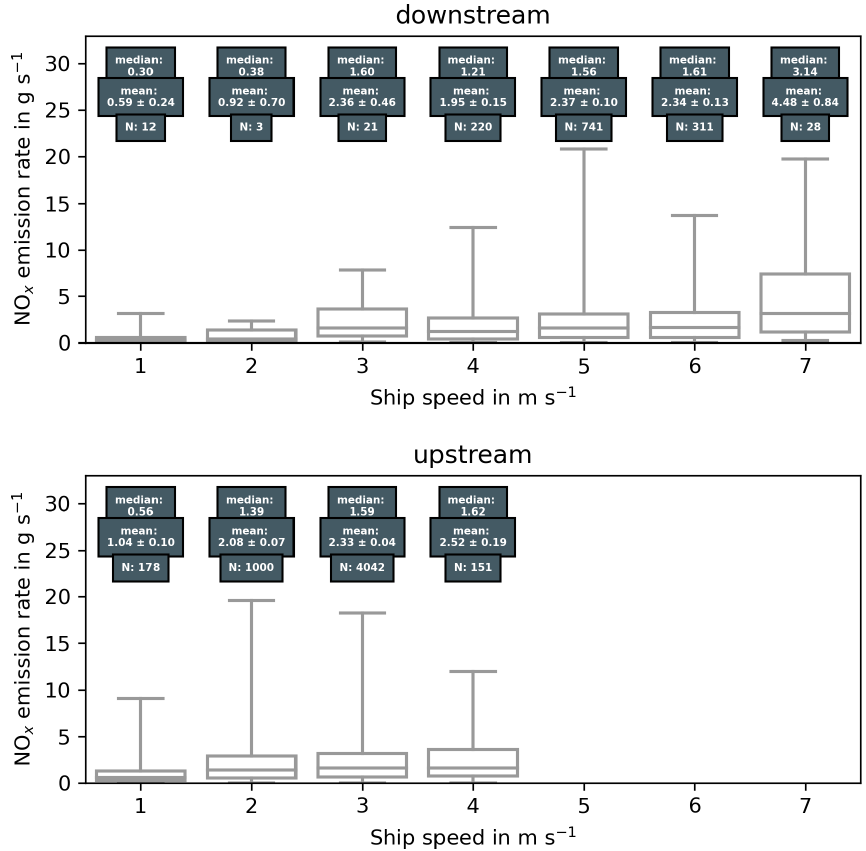
Figure 8. NO x emission rates for ship class Va and their dependence on the direction of travel and ship speed over ground, as derived from data measured at